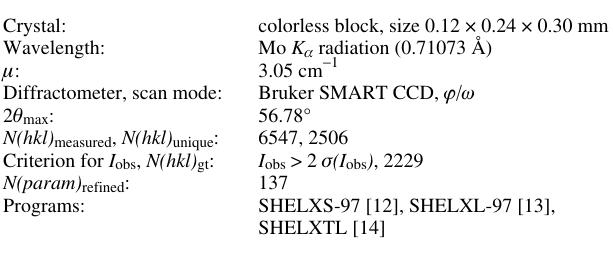
Table 1. Data collection and handling.